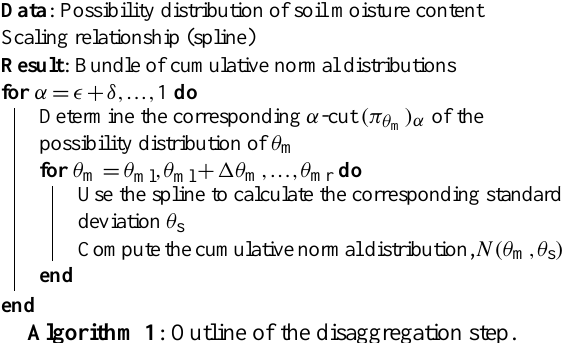
Algorithm 1 : Outline of the disaggregation